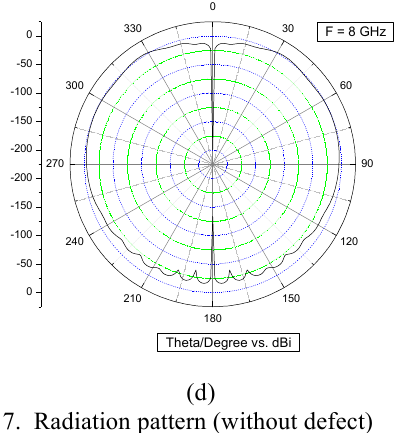
Figure 7. Radiation pattern (without defect) (a) Directivity Abs (Phi = 0) Theta/Degree vs. dBi (6